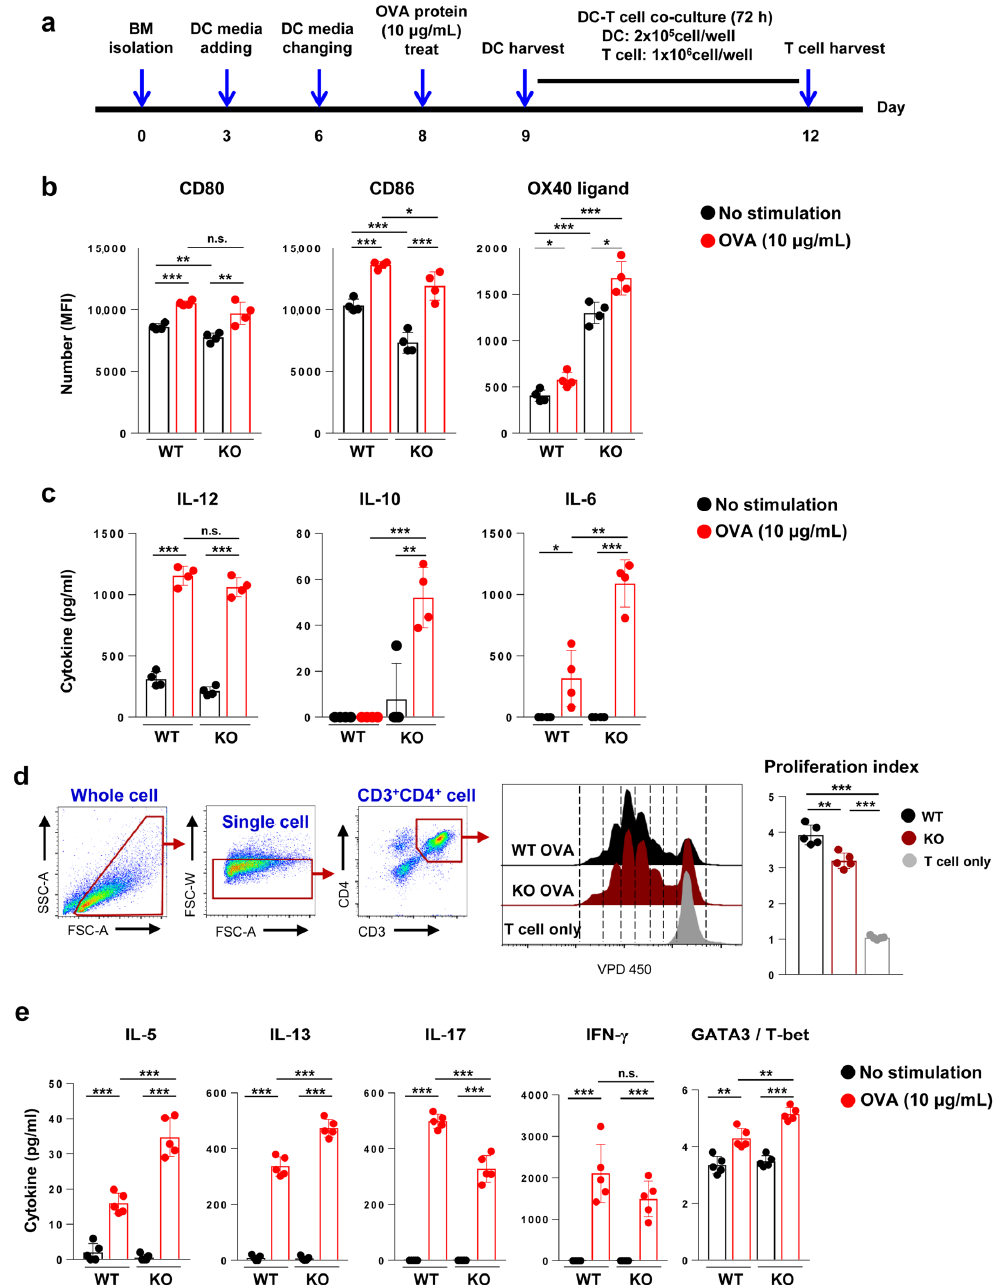
Figure 5. Comparison of Th2-inducing ability of bone marrow-derived dendritic cells Figure 5